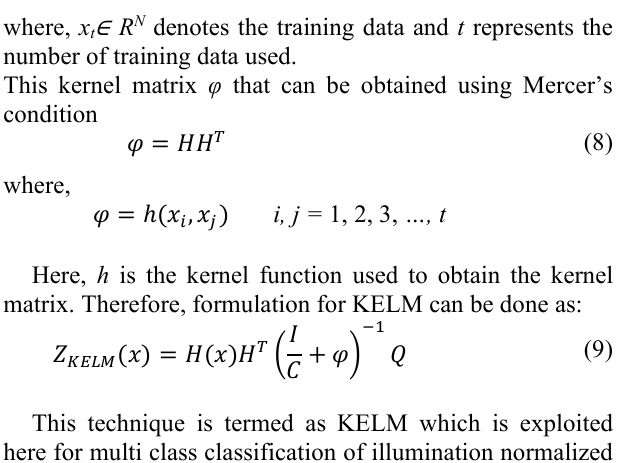
Figure 1. Architecture of KELM